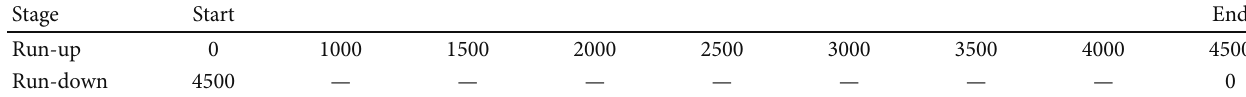
Figure 24: Orbit of the shaft at the rear bearing in di ff erent cases. (a) Case 1. (b) Case 2. (c) Case 3. (d) Case 4. (e) Case 1. (f) Case 2. (g) Case 3. (h) Case Table 6: Speed change of the rotor system during the test (unit: rpm).